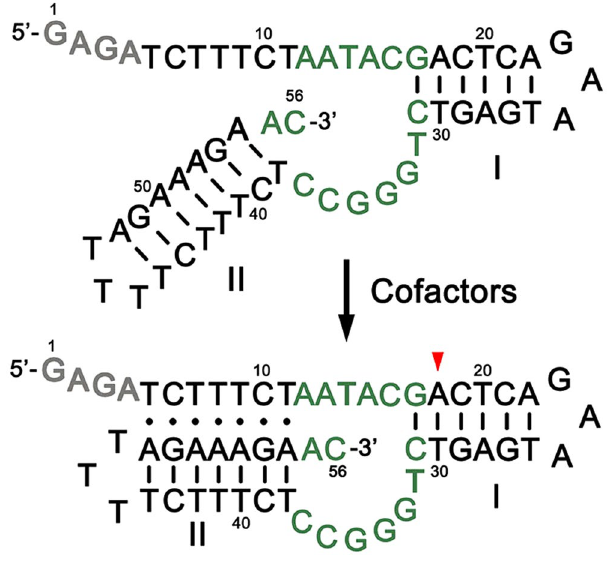
Figure 1. The sequence and secondary structure of a cis pistol-like DNAzyme. The green letters correspond to the conserved nucleotides of catalytic core. The red arrowhead indicates the major site of DNA cleavage. I and II designate stem-loop structures, where lines indicate Watson-Crick base pairs and dots represent triplex